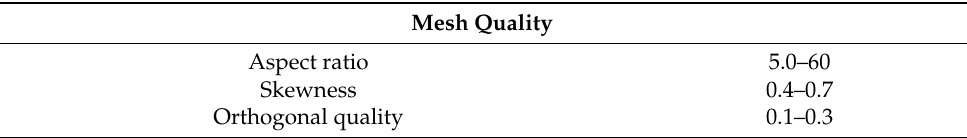
Table 2. The mesh quality of the simulation